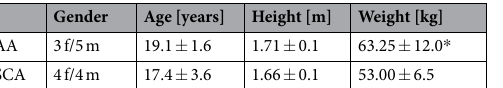
Table 2. Anthropometric data of healthy control (AA) and sickle cell anaemia patients (SCA). Data are mean ± s.d. * P = 0.03 SCA vs